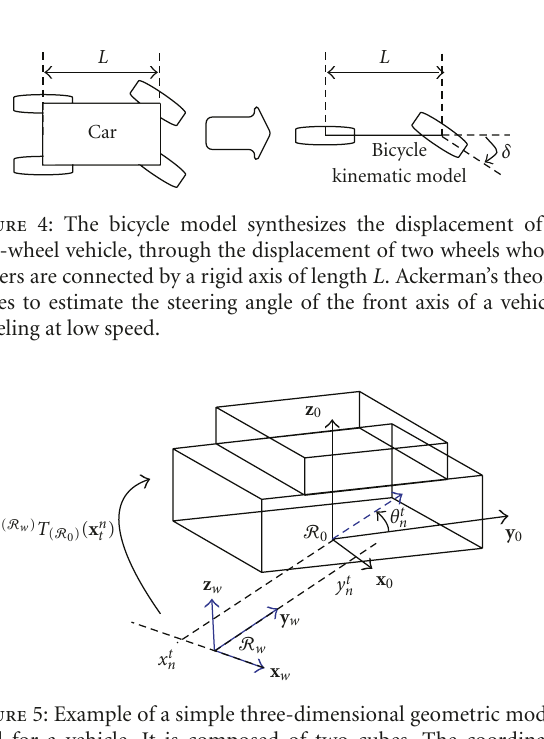
Figure 5: Example of a simple three-dimensional geometric model used for a vehicle. It is composed of two cubes. The coordinate system associated with the cube and the other system associated with the scene are related according to pure translation. The plane ( Oxy ) of the world coordinate system and component axes are merged with the GPS coordinate